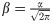
Changes in G and N for the AU model as a function of trial number.Different rows correspond to different mean reward μr (indicated left of each row), and different columns correspond to different standard deviations of reward σr (indicated above each column). The rewards were sampled from a Gaussian distribution. Here, both G and N were initialized at 0, and we set α = 0.1. We have selected β=α2π in order to make the figure easier to interpret, because then α2βE(|r-μr|)=σr, and hence in the middle row G and N approach σr. For each of the panels, the simulation was run 50 times, for 100 trials each.